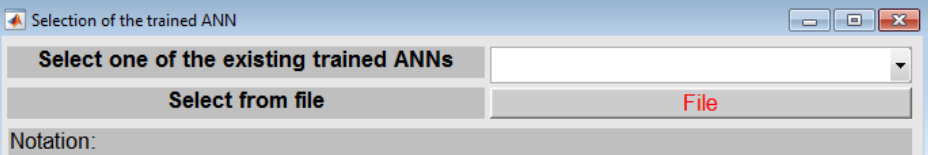
Figure 10. The window used for the presentation of the final results ( a ) before and ( b ) after running. When the push button entitled “PREDICTION OF DAMAGE LEVEL” is used, the window of Figure 11 is activated. This window enables the selection of the trained MFPNN that will be used to estimate the DS (SDC) of the studied RC building for the input earthquake ground motion selected.